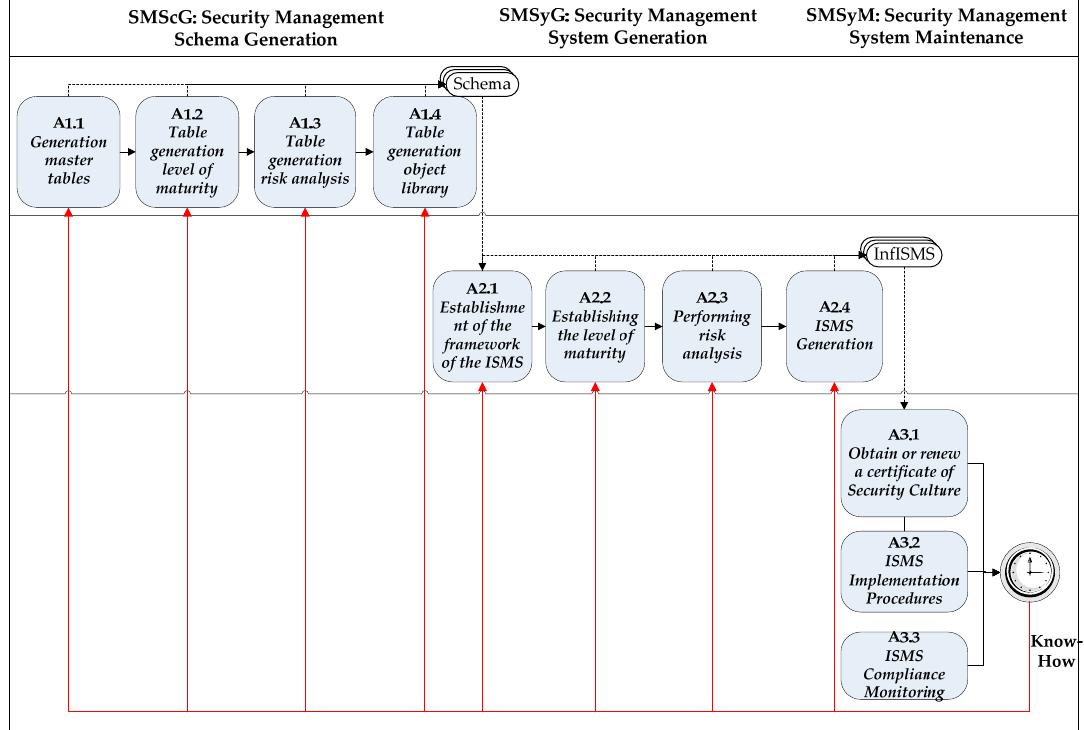
Figure 2. Sub ‐ processes of the methodology MARISMA. Figure 2. Sub-processes of the methodology